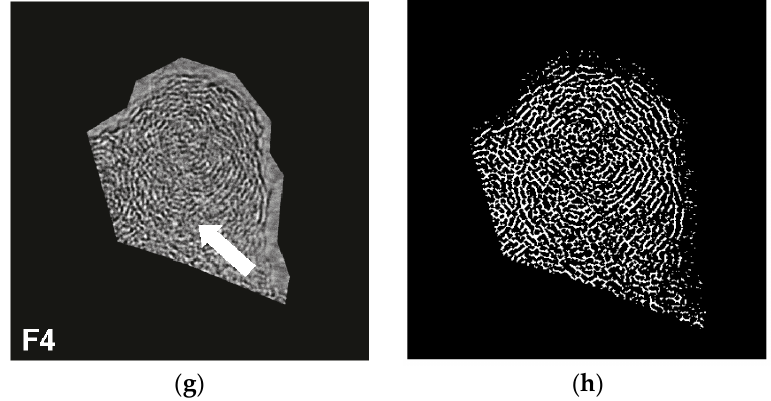
Figure 5. Image processing results of nascent soot particles under different conditions: ( a , b ) pure ethylene; ( c , d ) 1-pentanol/ethylene; ( e , f ) 3-methyl-1-butanol/ethylene; ( g , h ) 2-methyl-1-butanol/ethylene.